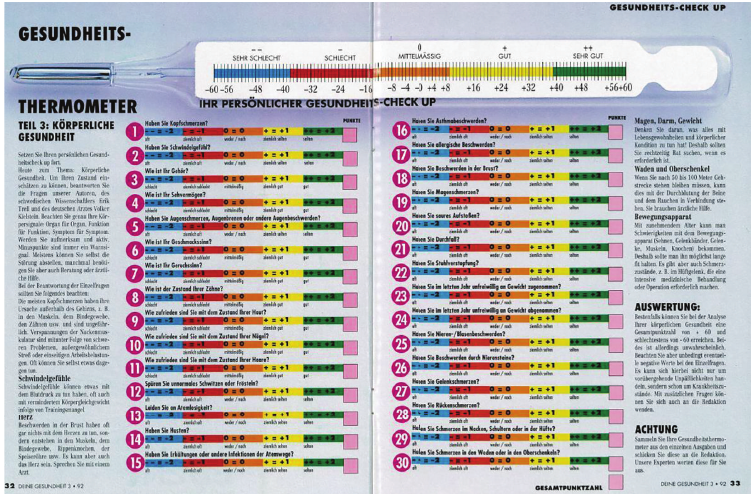
Figure 2: Physical health Gesundheit-Thermometer in issue of Deine Gesundheit, with summing-up scale on